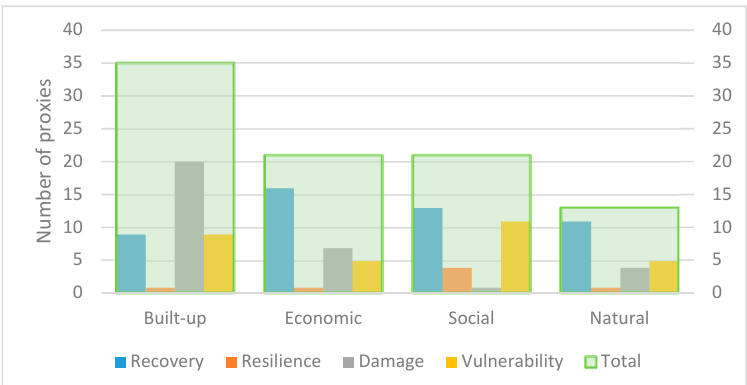
Figure 2. Number of developed remote sensing-based proxies for DRM in each environment (Built-up, Economic, Social, Natural). The proxies that are used interchangeably in more than one area, e.g., damage and recovery assessments, are counted on all of the used categories separately. However, the green colored bar shows the total number of unique RS-based proxies for each environment.